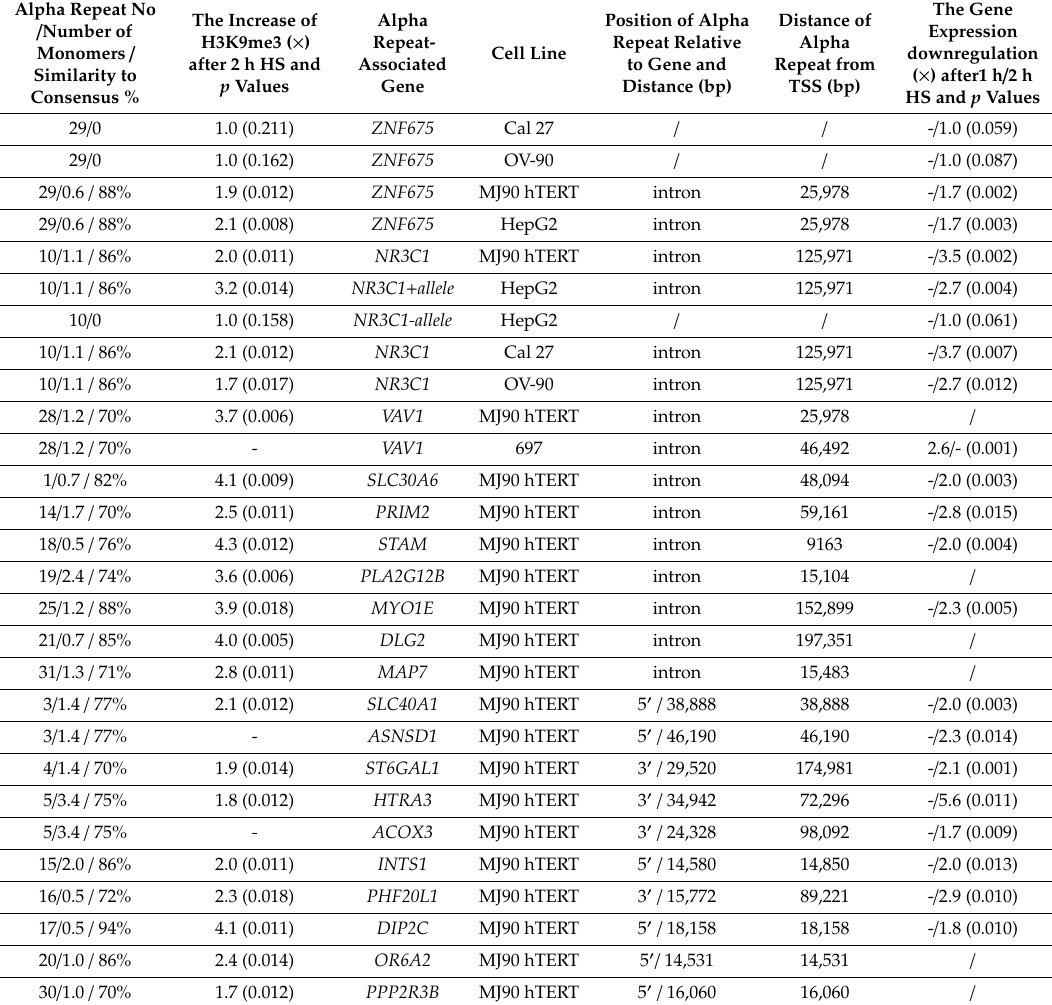
Table 1. The increase of H3K9me3 level at dispersed alpha repeats immediately after heat stress as well as the level of downregulation of alpha repeat-associated genes in di ff erent human cell lines. Alpha repeat No, number of monomers within repeat, and similarity to alpha satellite consensus sequence is indicated as well as positions and distance of alpha repeats relative to genes and their distance from TSS. The p -values are calculated using the unpaired t -test. (- not determined; / not